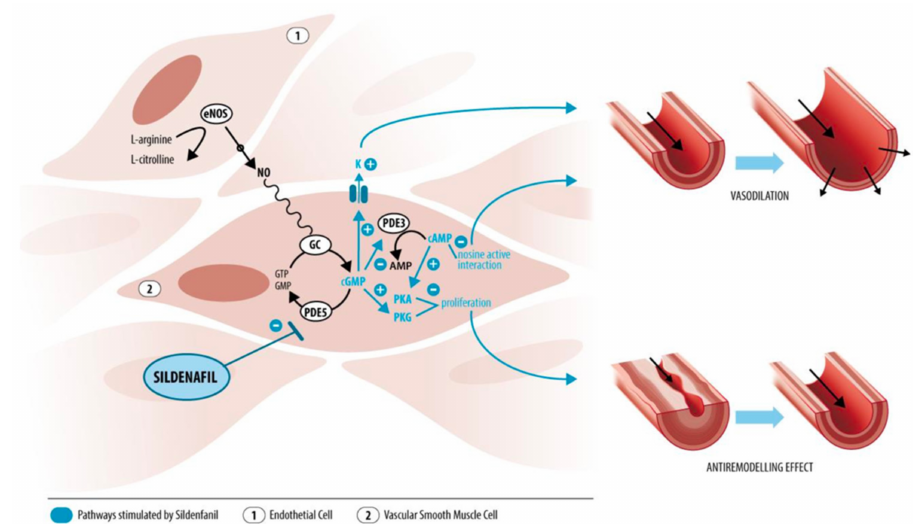
Figure 1. Nitric oxide pathway. Schematic representation of the mechanism of action of silde- nafil on the pulmonary vasculature. eNOS, endothelial nitric oxide synthase; NO, nitric oxide; GC, guanylate cyclase; GTP, guanosine triphosphate; GMP, guanosine triphosphate; cGMP, cyclic GMP; PDE, phosphodiesterase; ATP, adenosine triphosphate; AMP, adenosine monophosphate; cAMP, cyclic AMP; PKG, cGMP-dependent protein kinase; PKA, cAMP-dependent protein kinase. Reprinted with permission from [6], 2022, Bentham Sciences. Drawing: Myrthe